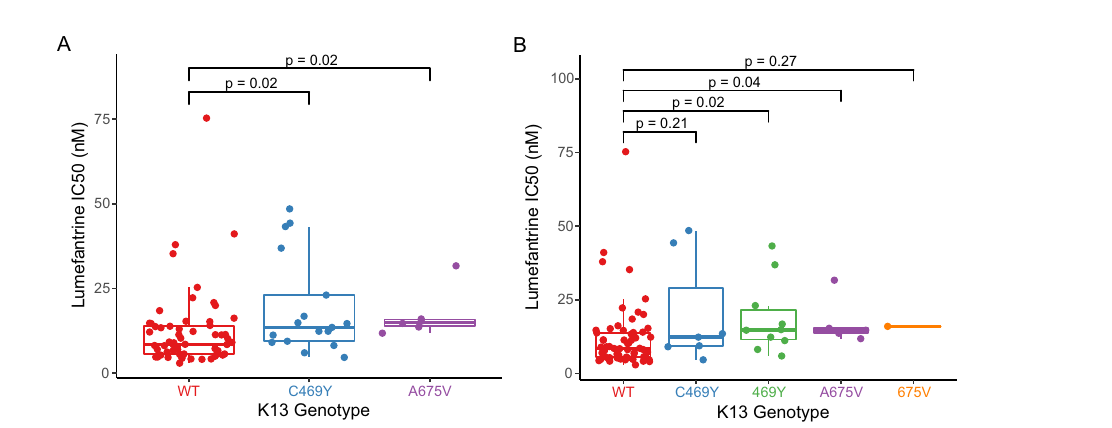
Fig.5|LumefantrinesusceptibilityofparasiteswithdifferentPfK13genotypes. Eachpointrepresentstheresultforasingleisolate( A n =61WT,17C469Y,6A675V; B n =61WT,7C469Y,10469Y,5A675V,1675V).Resultsareshownwithmixedand pure mutant isolates combined ( A ) or shown separately ( B ). P -values were deter- mined using the two sided Mann – Whitney Wilcoxon test. Center bounds of boxes